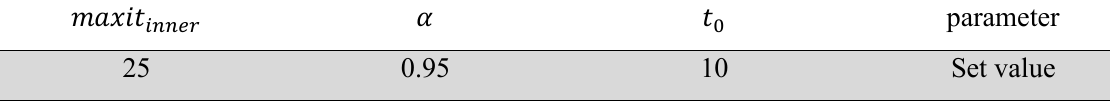
Adjusted values of the MOSA algorithm